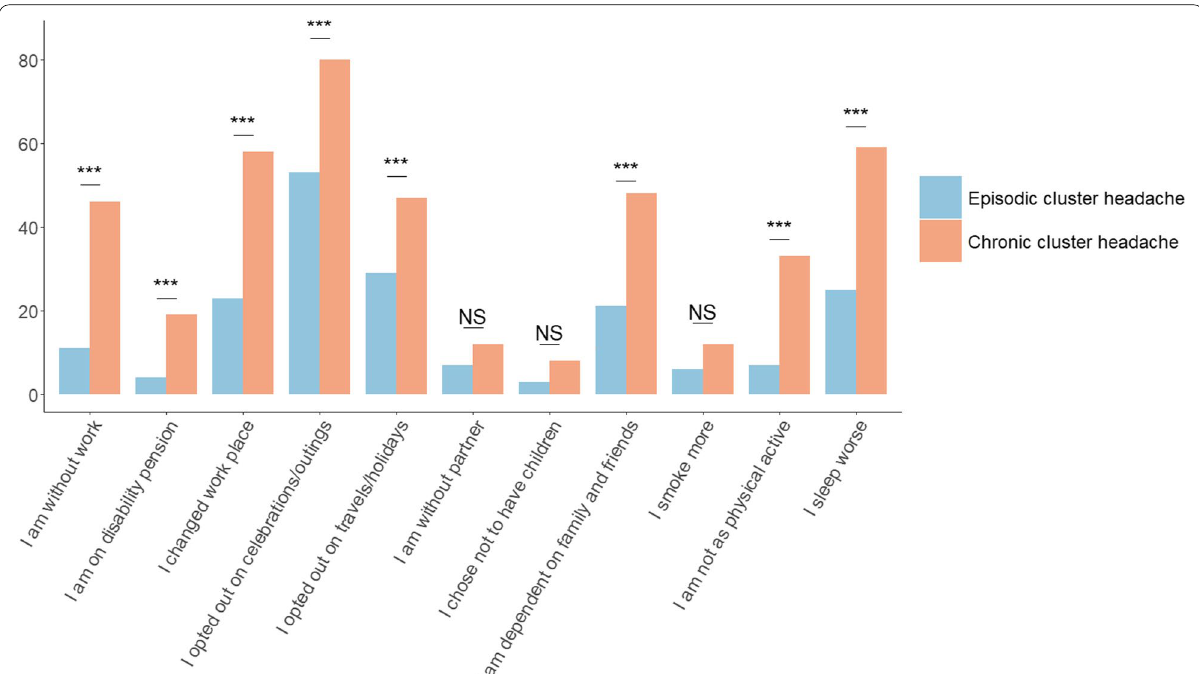
Fig. 3 Negative impact of cluster headache on professional, social and family life. Legend: Self-reported impact of cluster headache on different aspects of everyday life. Data presented for 399 chronic and episodic cluster headache patients. Bonferroni correction was applied. *** p Not